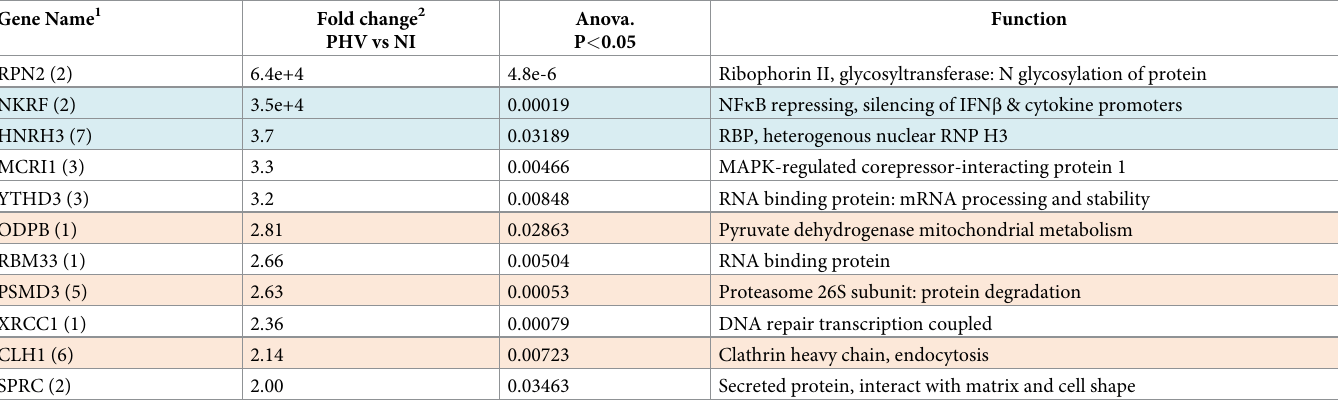
Table 4. Human proteins found in complex with PHV-N in HEK293T cells.